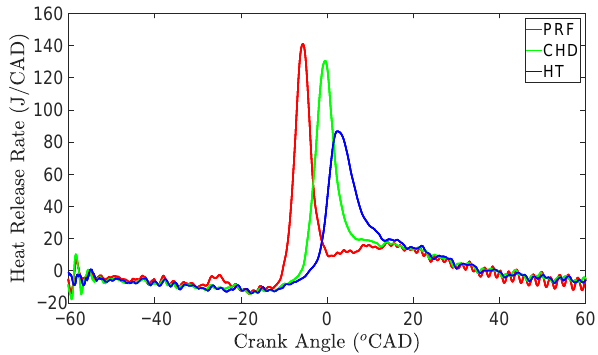
Figure 10. Heat release rate for the three fuels with T inlet 115 ◦ C.